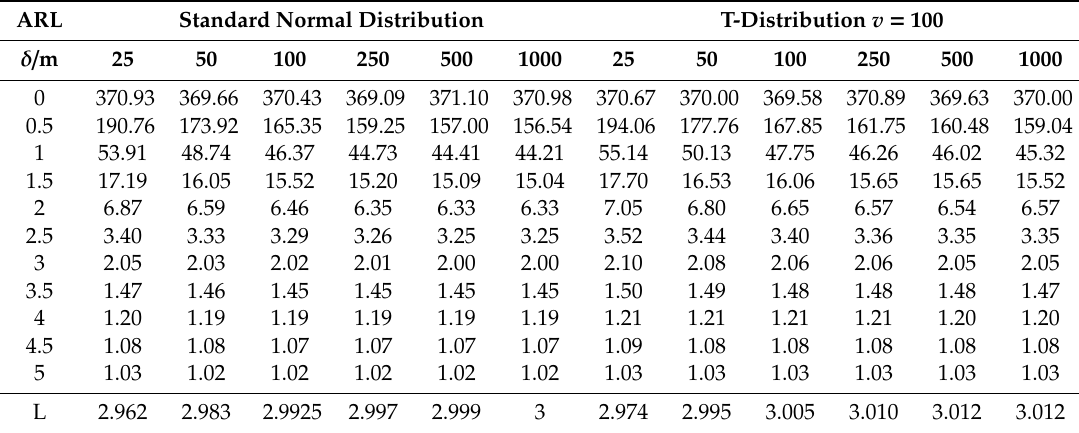
Table 1. Average run length (ARL) of the Shewhart chart with estimated parameters for standard normal and t ( v = 100) distributions. ARL Standard Normal Distribution